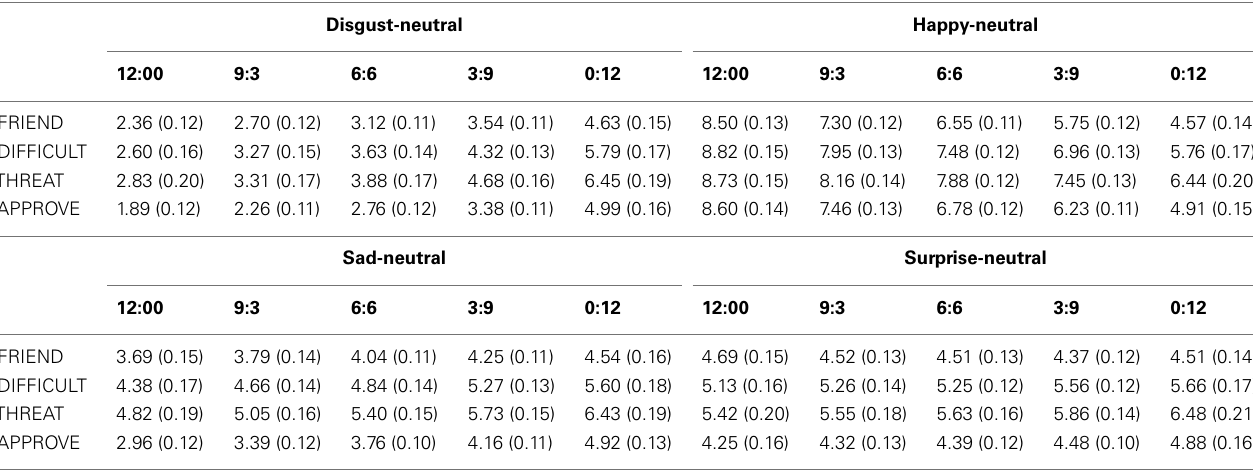
Table 4 | Mean scores, standard errors (in parentheses) per question (friendliness, FRIEND; Difficulty to make contact, DIFFICULT;Threat when giving a presentation;THREAT; approval by crowd,APPROVE), crowd type, and expression ratio (12:0 all-emotion: zero neutral to 0:12 zero emotion: